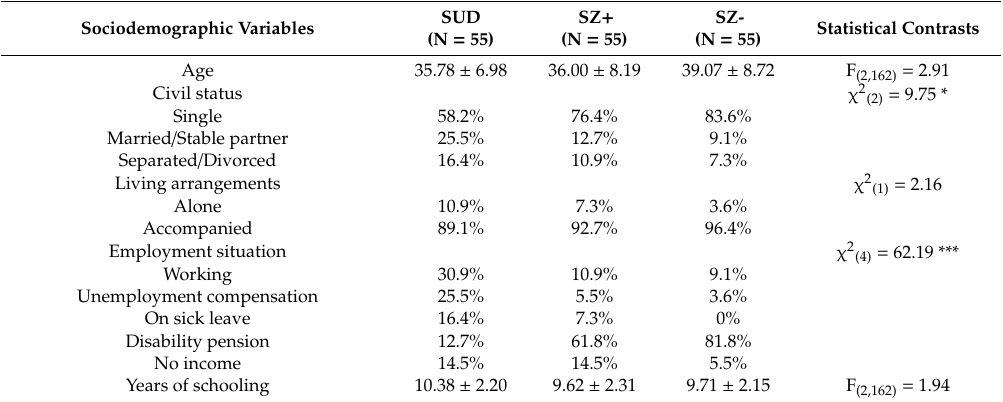
Table 1. Sociodemographic data for the three groups. Mean, standard deviation or percentages, and statistical